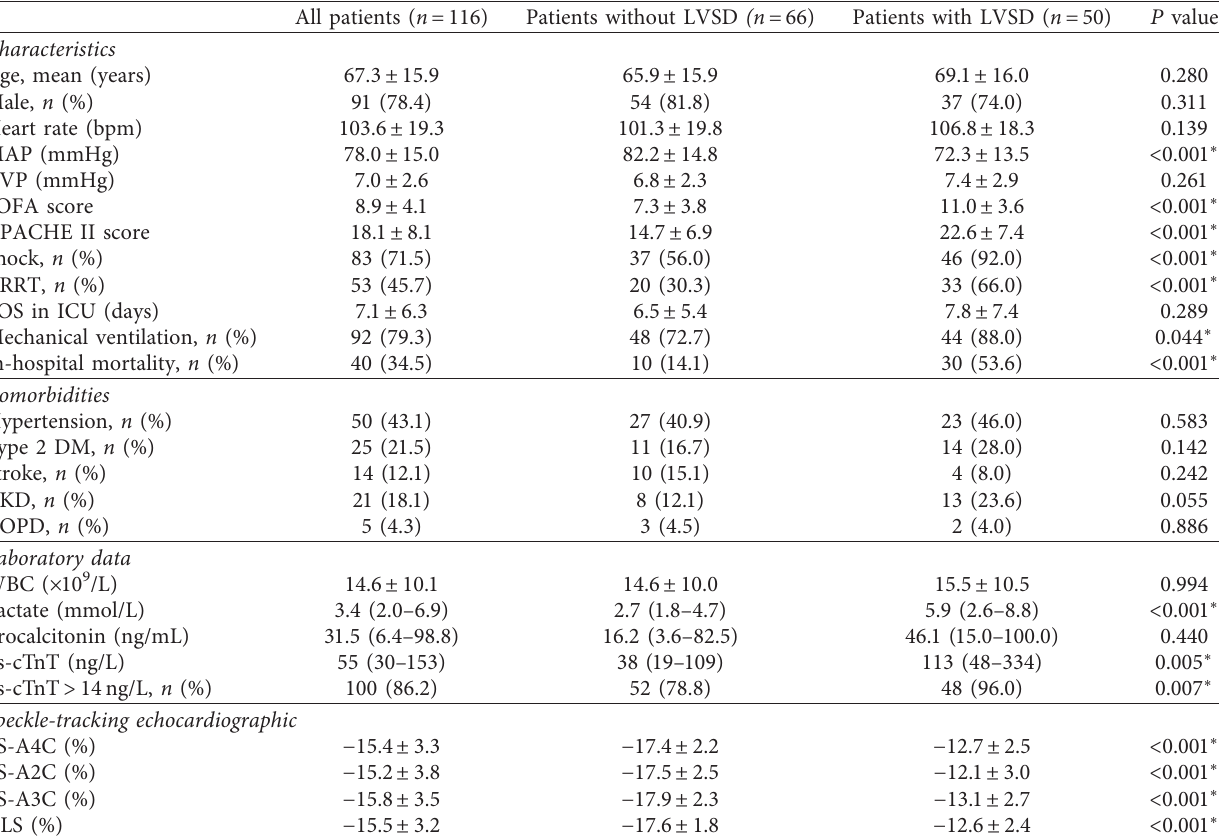
Table 1: Baseline characteristics, biochemical, hemodynamic, and echocardiographic data of patients classified in relation to the presence of left ventricular systolic